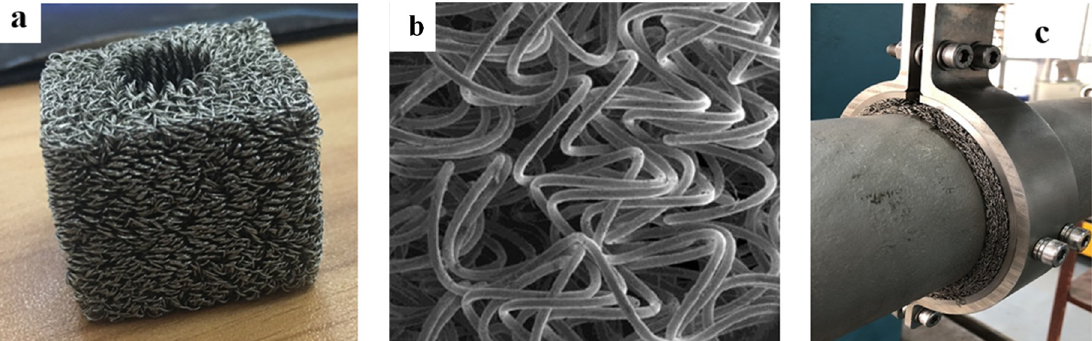
Figure 1. Macro/microstructure of MR and its application on pipeline vibration reduction: ( a ) Macro of MR; ( b ) microstructure of MR; ( c ) Application of MR.